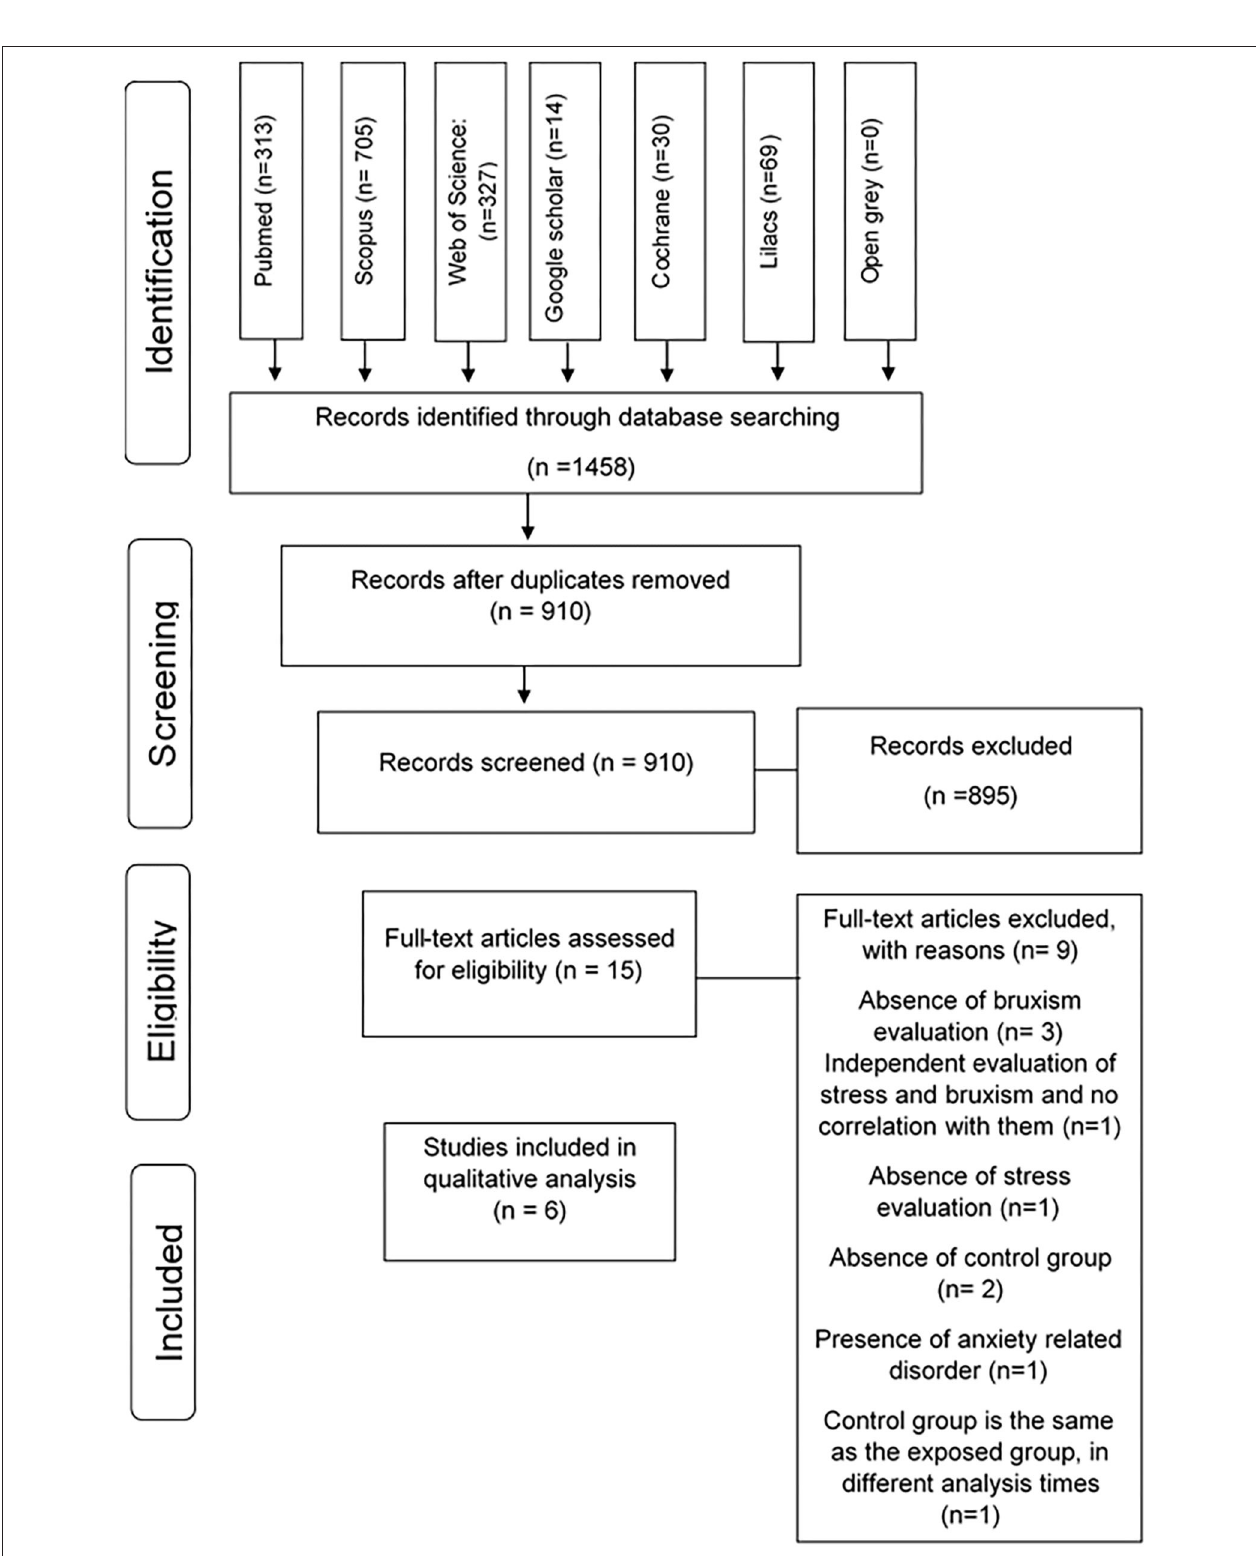
FIGURE 1 | Flow diagram of databases searched according to PRISMA guidelines (Preferred Reporting Items for Systematic Review and Meta-Analysis).